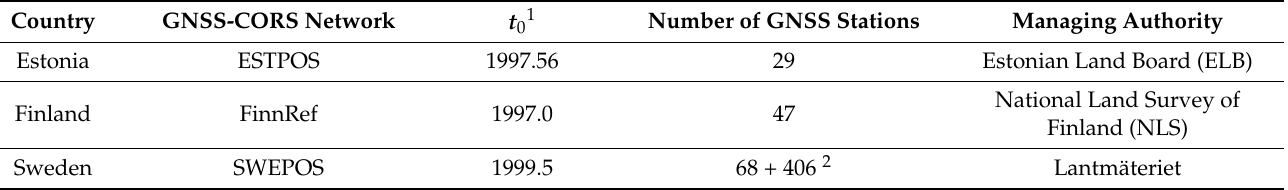
Table 2. National GNSS networks, corresponding t 0 and the number of active GNSS-CORS (in 2021) managed by national surveying authorities (Figure 2 shows GNSS-CORS that also belong to the EUREF Permanent GNSS